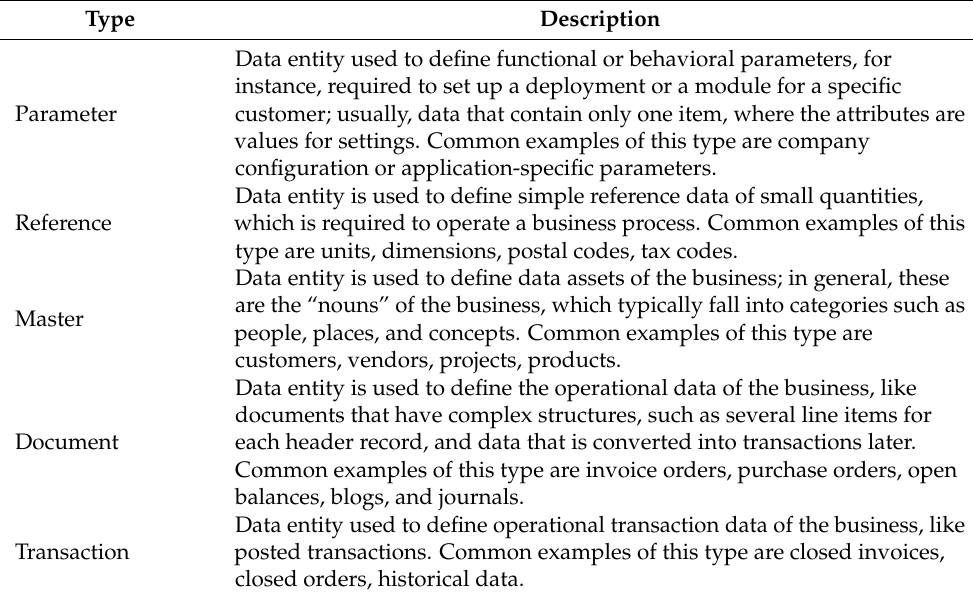
Table 1. DataEntity and DataEntityCluster types (adapted from